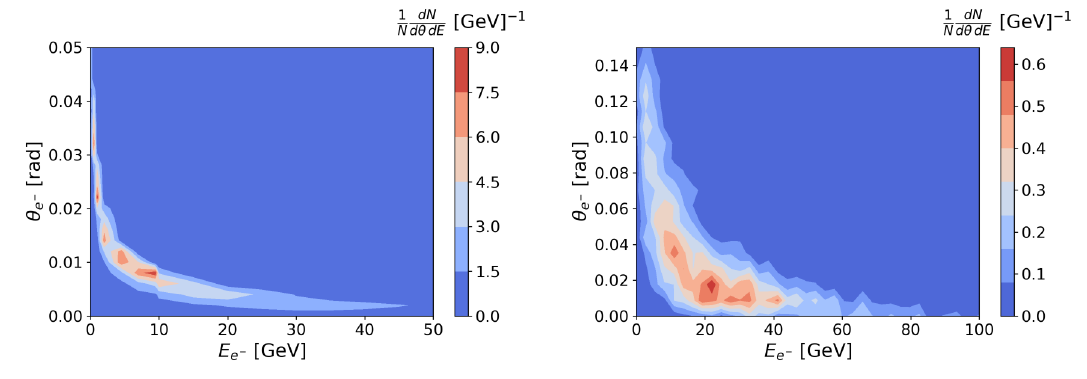
Vs. angle θ for the relevant background e − e − (¯ ν ) being ‘ = e, µ ; (b) ‘ ‘